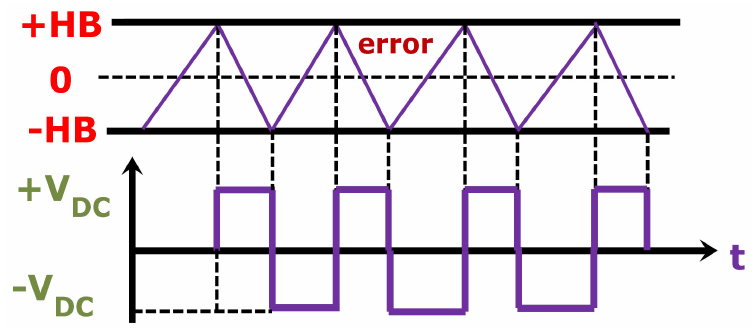
Figure 4. Analysis of conventional hysteresis band current controller [48].